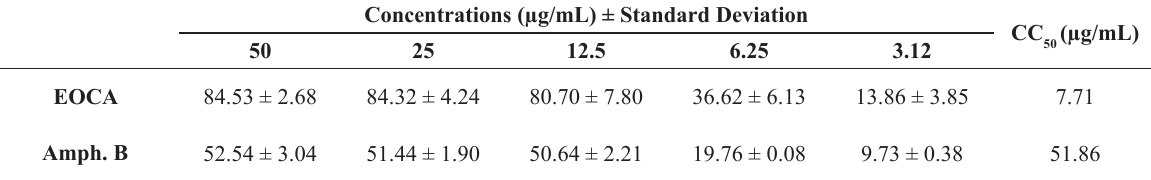
Cytotoxicity of the leaf essential oil of C. aschersoniana and Amphotericin B. Concentrations (µg/mL) ± Standard Deviation